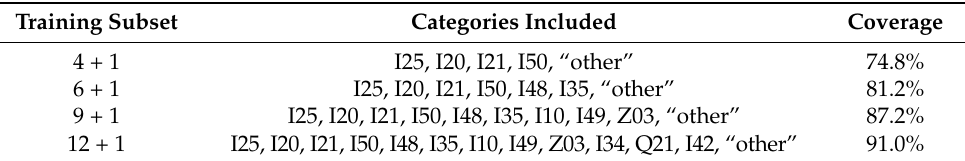
Table 4. Overview of the training subsets listing individual ICD-10 categories included in the training and coverage of such a subset with respect to the whole dataset.